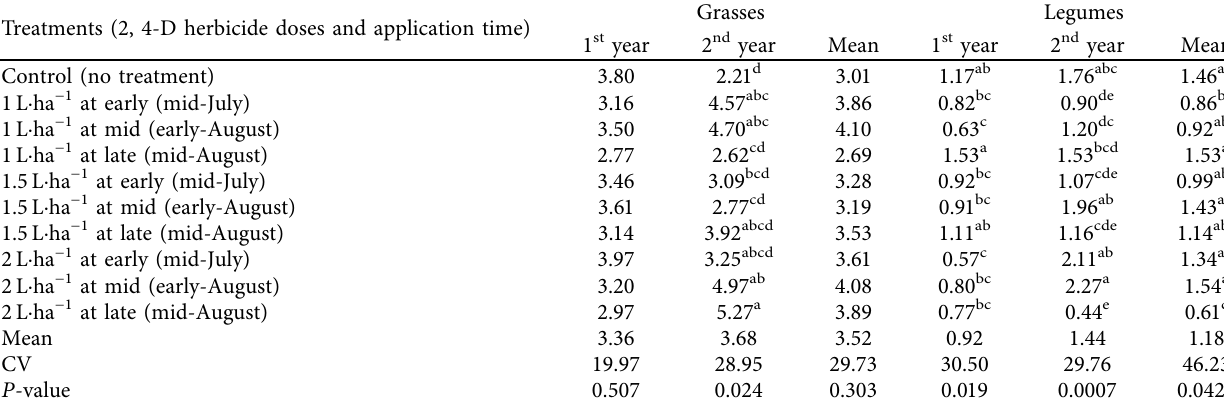
Table 9: Effect of dose and time of application of 2, 4-D herbicide on dry matter yield (t · ha − 1 ) of natural pasture forage species. Treatments (2, 4-D herbicide doses and application time)